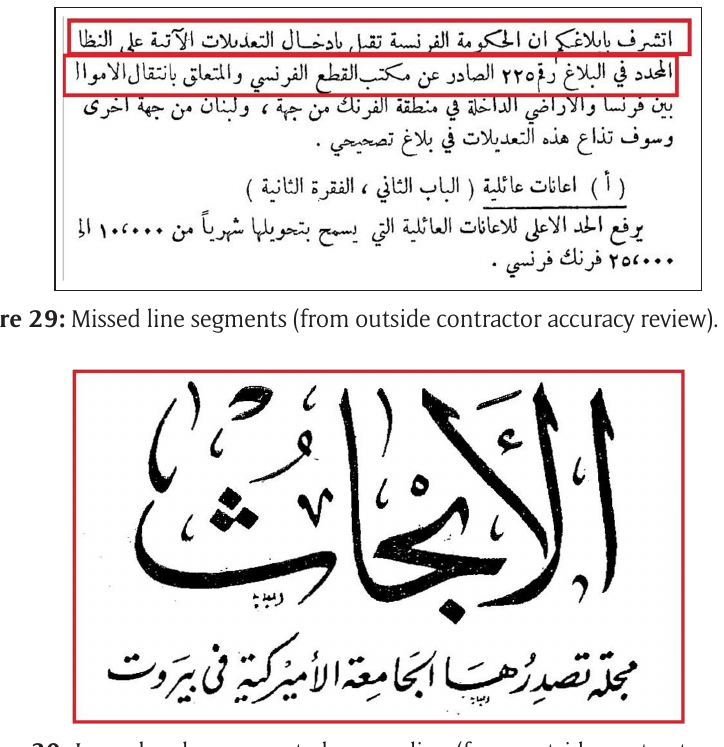
Figure 30: Large header segmented as one line (from outside contractor accuracy review).